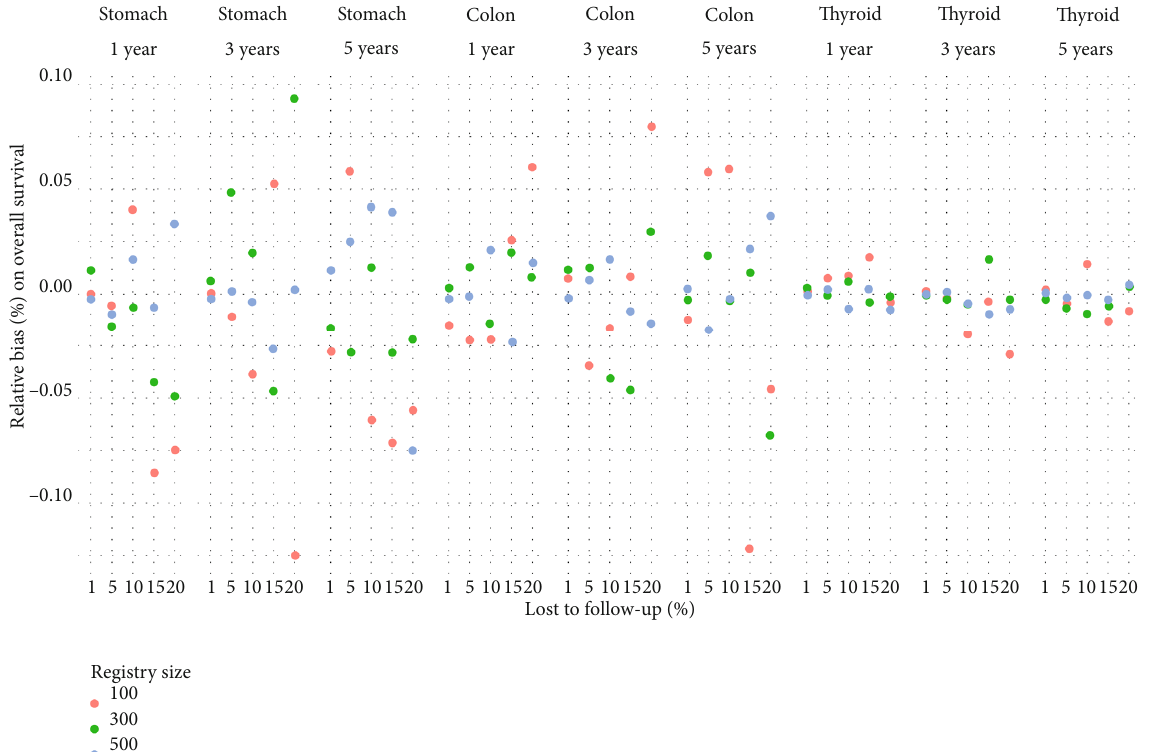
Figure 5: Relative bias (%) on net survival due to excluding lost to follow-up cases by cancer localization, follow-up time, percentage lost to follow-up, and registry